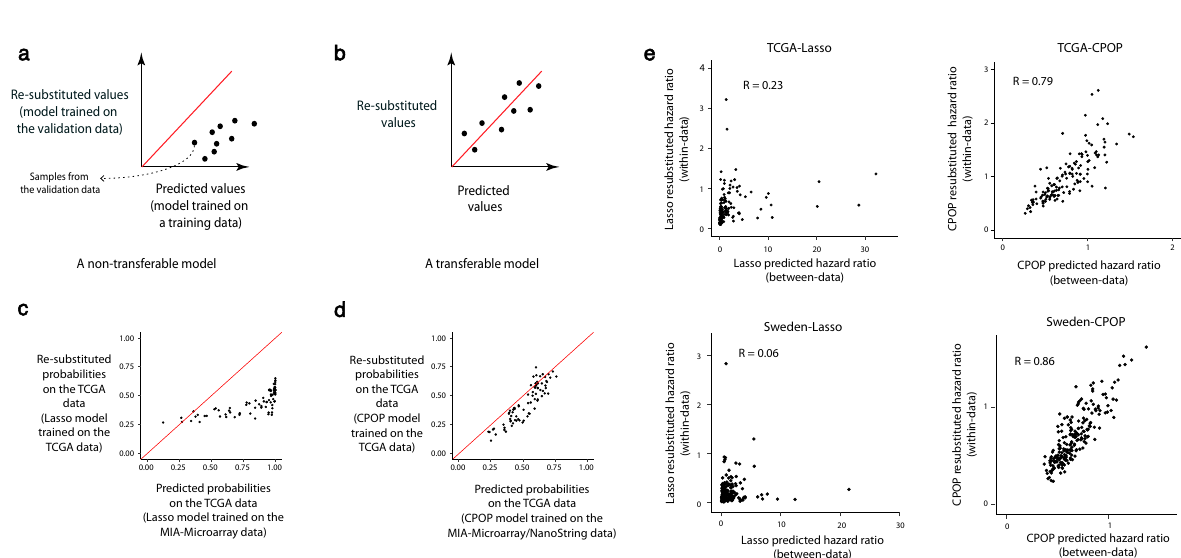
Included are the number of samples, the median age of the cohort, gender (sex), the median survival time in month and survival status. OS, RFS and DSS refer to overall survival, recurrence-free survival and disease-speci fi c survival, respectively.